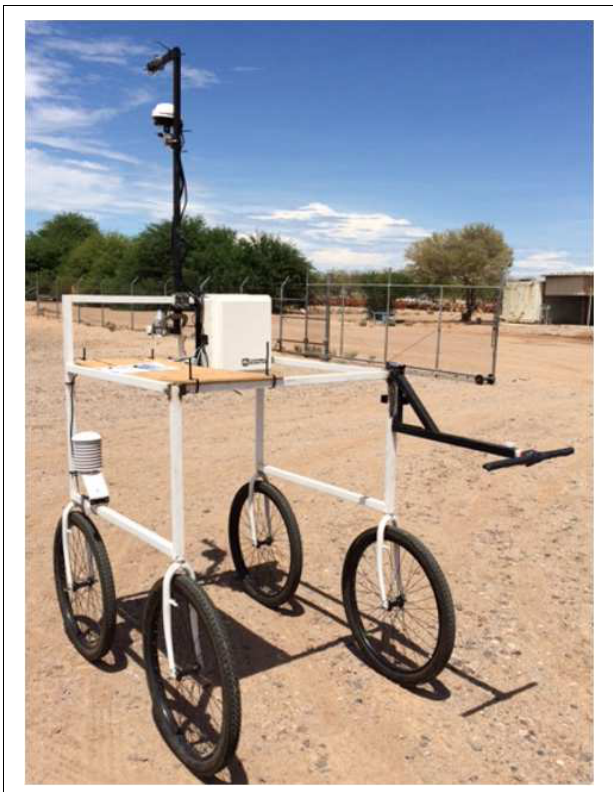
FIGURE 1 | Proximal sensing cart with a sensor bar, data logger, sensors, and extended handle. Camera sensor bar and cameras are not